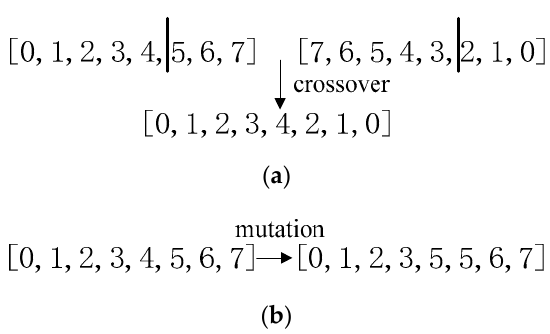
Figure 3. The crossover and mutation operator of GA: ( a ) crossover; and ( b ) mutation.